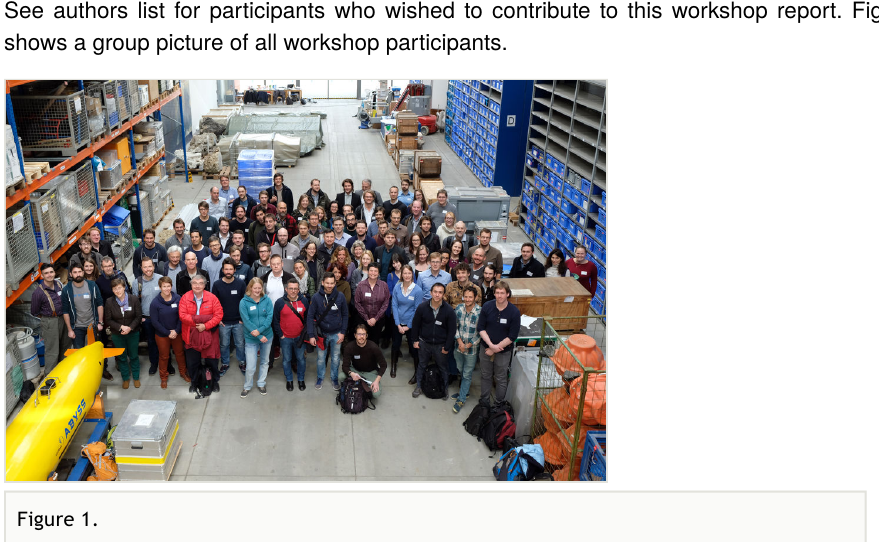
Participants of the Marine Imaging Workshop 2017 in the Lithothek of GEOMAR (Photo: Jan Ste ff en,